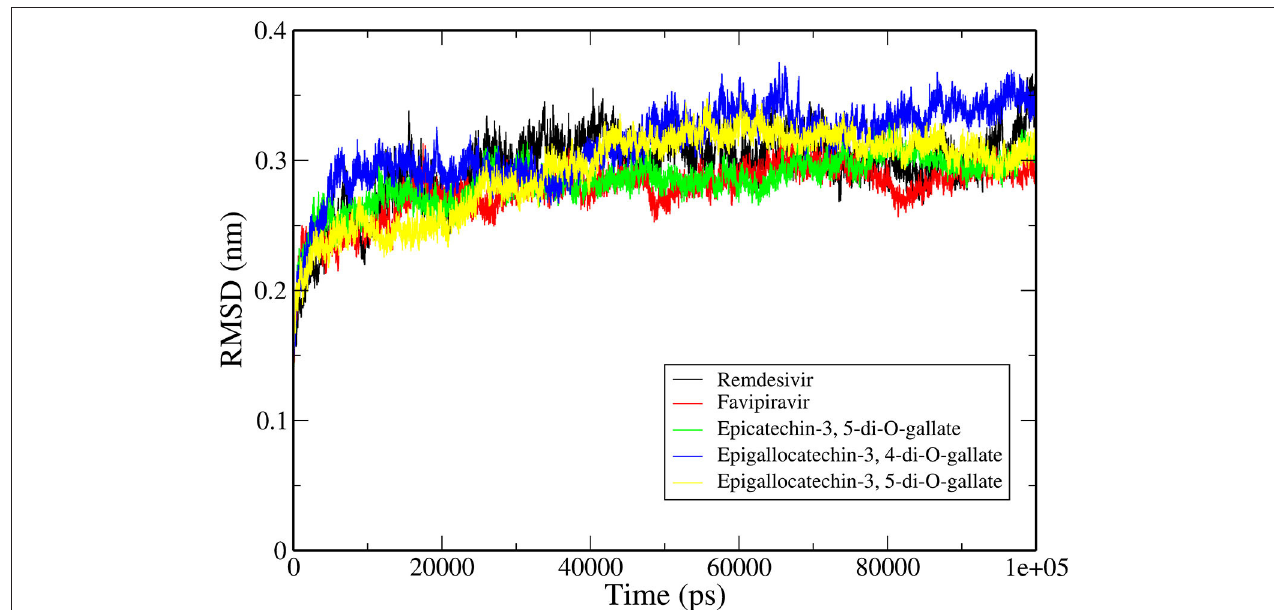
FIGURE 3 | Backbone RMSDs are shown as a function of time for the RNA–RdRp complex of SARS-CoV-2 and ligands.